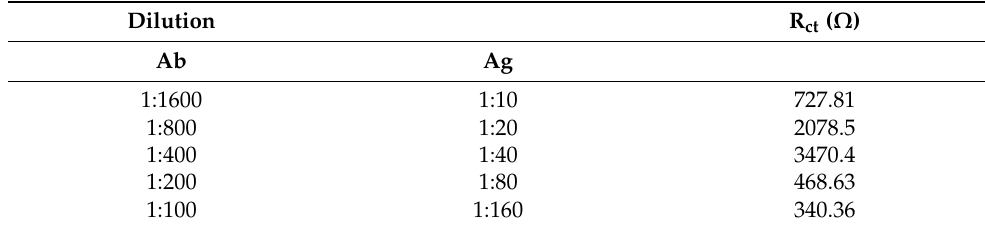
Table 2. Effect of antibody and antigen dilution on the immunosensor response.